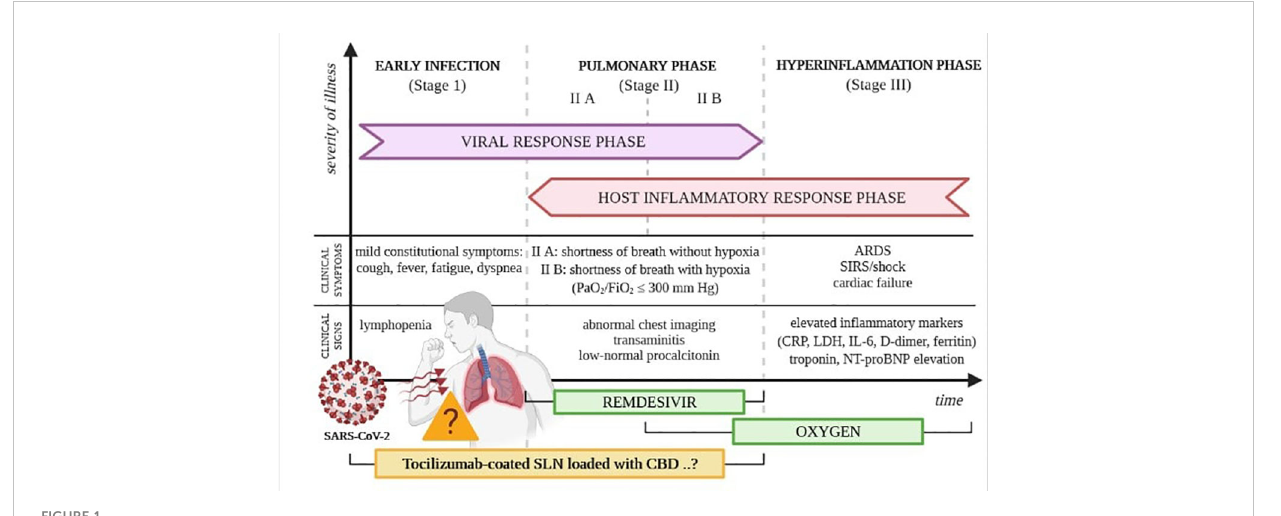
FIGURE 1 Phases of the clinical course of COVID-19. Own drawing, based on